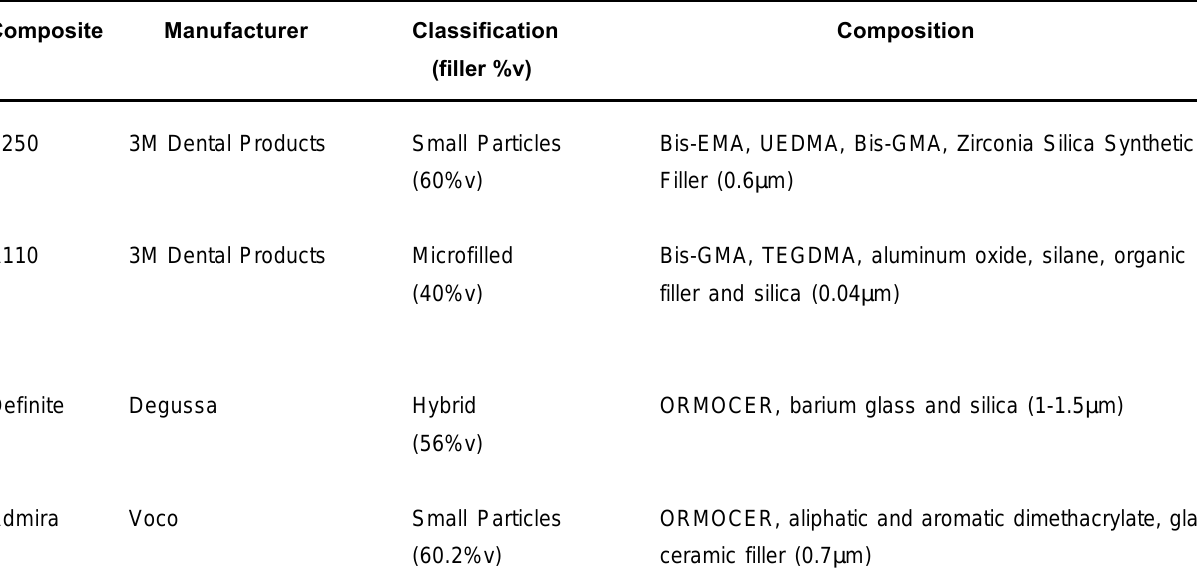
TABLE 1 - List of composites used, manufacturers, composition and batch